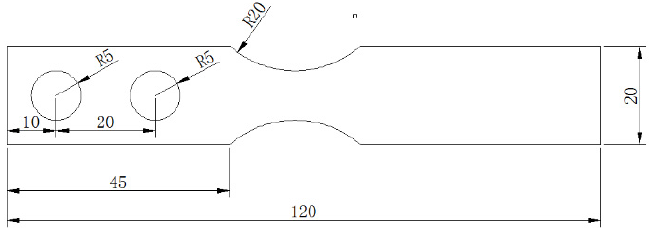
Figure 2. Shape and dimensions of the KMN vibration fatigue specimen (mm).